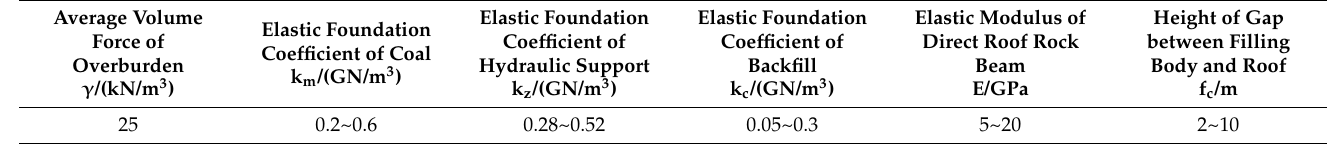
Table 3. Value range of influencing factors of roof